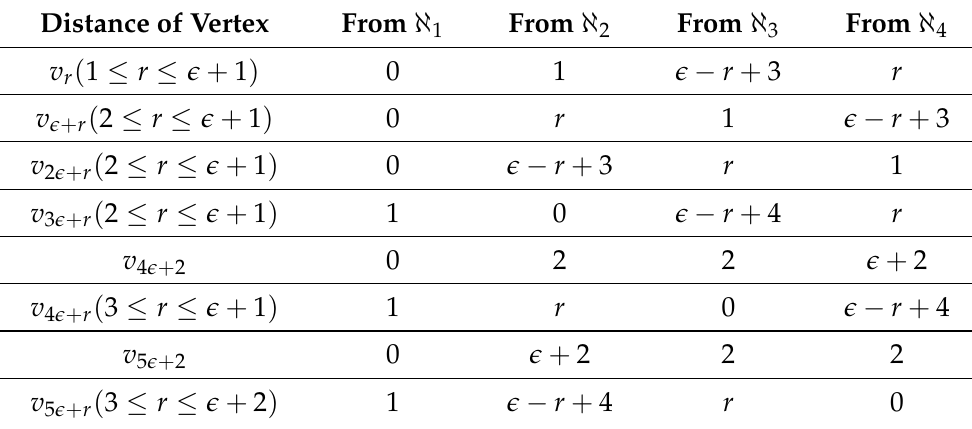
Table 9. Distance codes of V ( f α × 3 ) with respect to ℵ .